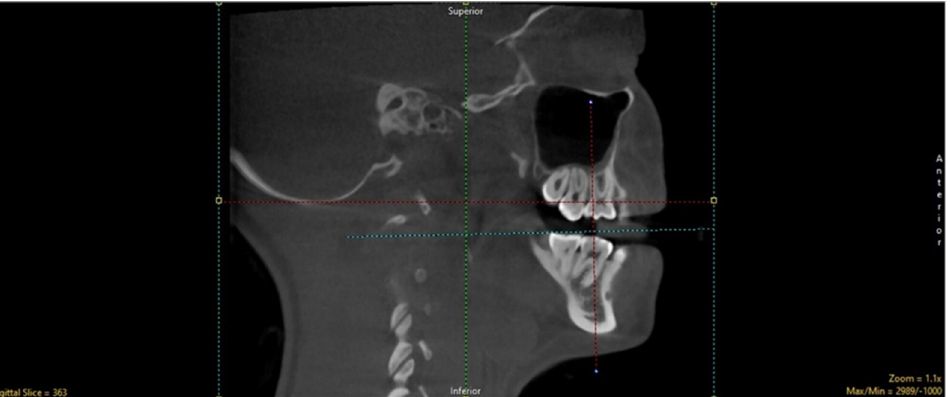
Figure 1. Selection of the region of interest (the dotted lines represent the orientation for the se- lected ROI).